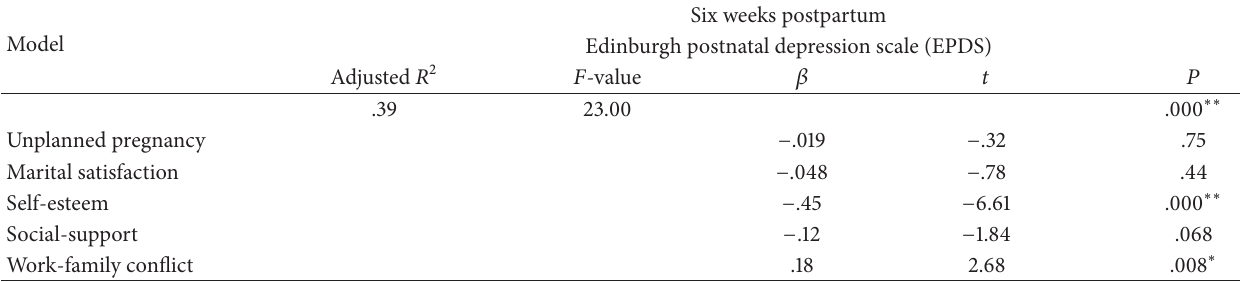
Table 7: Hierarchical multiple regression analysis of significant psychosocial risk factors for EPDS scores at six weeks